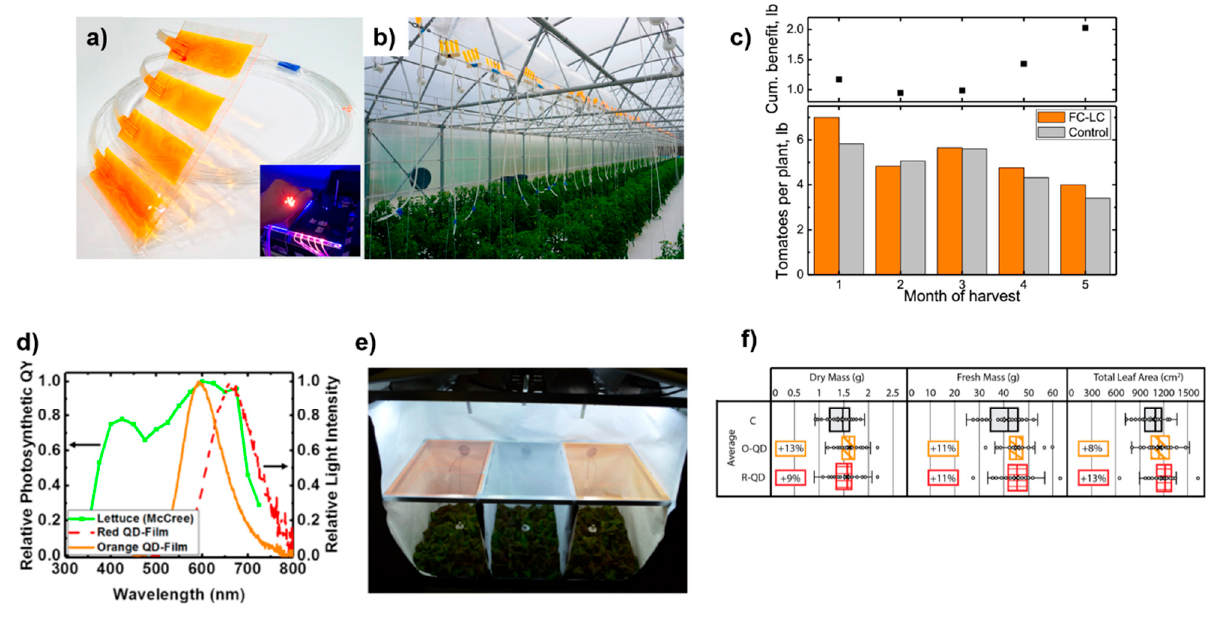
Figure 6. ( a ) Photographs of the fiber-LSC system developed for greenhouses. Inset shows emission from the fibers under blue LED excitation. ( b ) Fiber LSC collectors deployed over a row of tomatoes in a commercial hydroponic greenhouse. ( c ) Comparison of the tomato crop yield with and without using LSC devices; reprinted with permission from Ref [62]. Copyright 2019 American Chemical Society. ( d ) The emission spectra of the two types of QD (orange@600 nm and red@660 nm) over- lapped on the photosynthetic response curve for lettuce. ( e ) Photograph of the LSC devices. Three similar areas were used to compare the effects of the different light spectra created by the QD films (left and right) compared to the control film (center) under a similar light intensity. ( f ) Average of three replicate lettuce experiments of measured edible dry mass, edible fresh mass, and total leaf area. Reprinted with permission from ref [63]. Copyright 2021 Springer Nature.